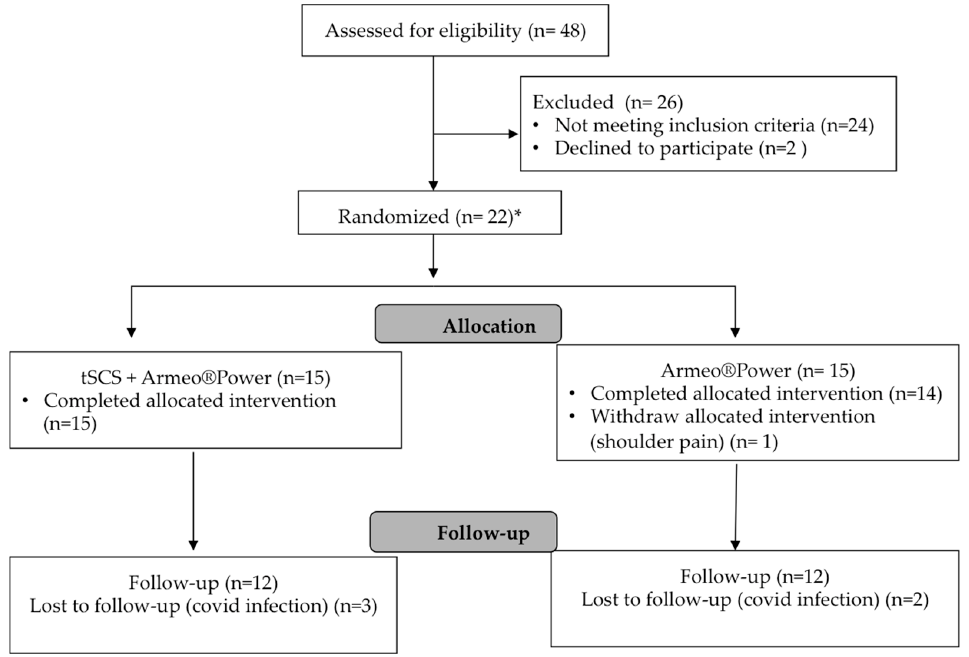
Figure 1. Flow diagram showing the number of subjects involved in each phase of the study. * 8 subjects were studied in both experiments (crossover) after at least 4 weeks of washout period. * crossover: five from the control group to the intervention group, and three from the intervention group to the control group.